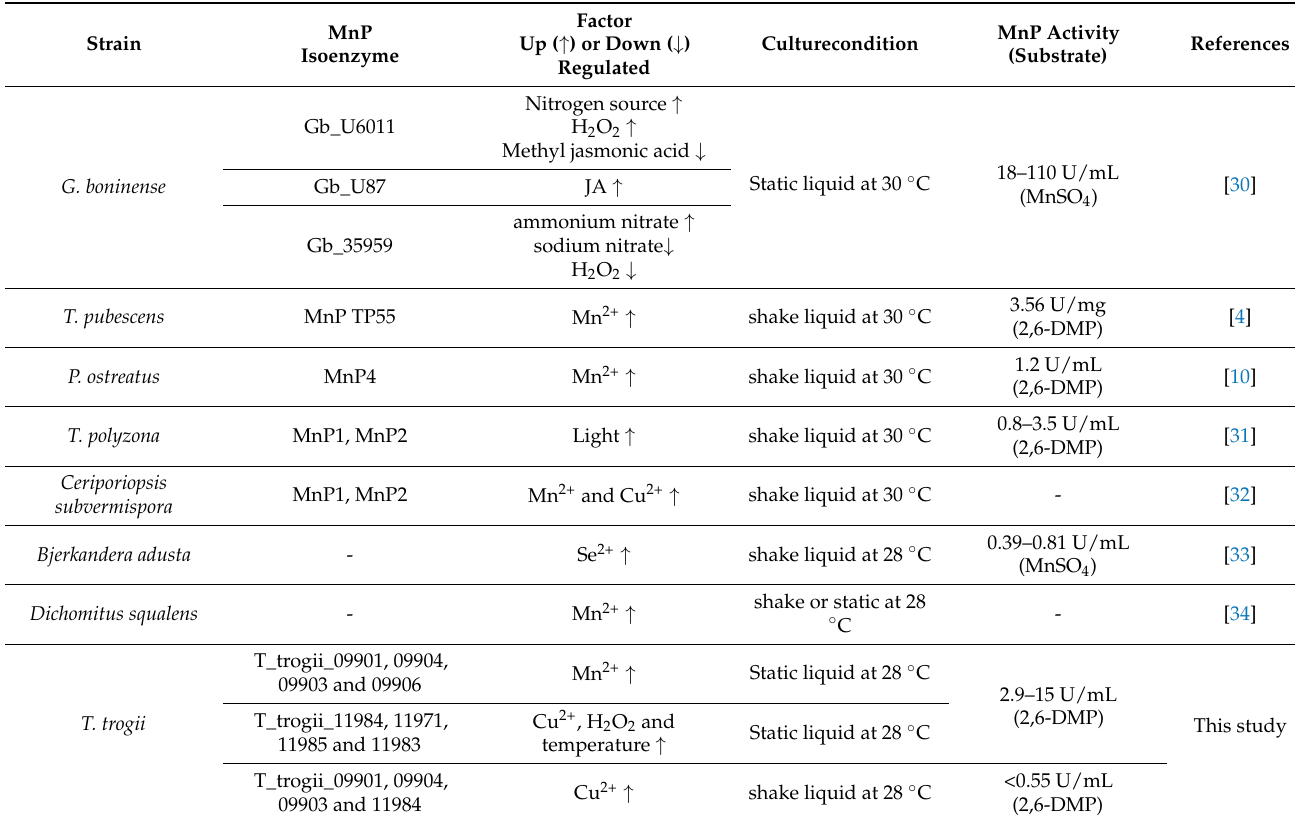
Table 1. The factors altering MnP transcript and activity in